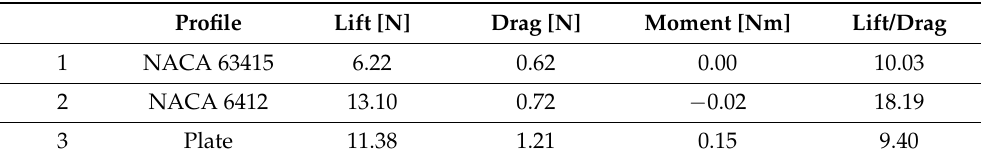
Table 2. Values of forces acting on selected profiles with a zero angle of attack at the inflow of a stream at 85 m/s.